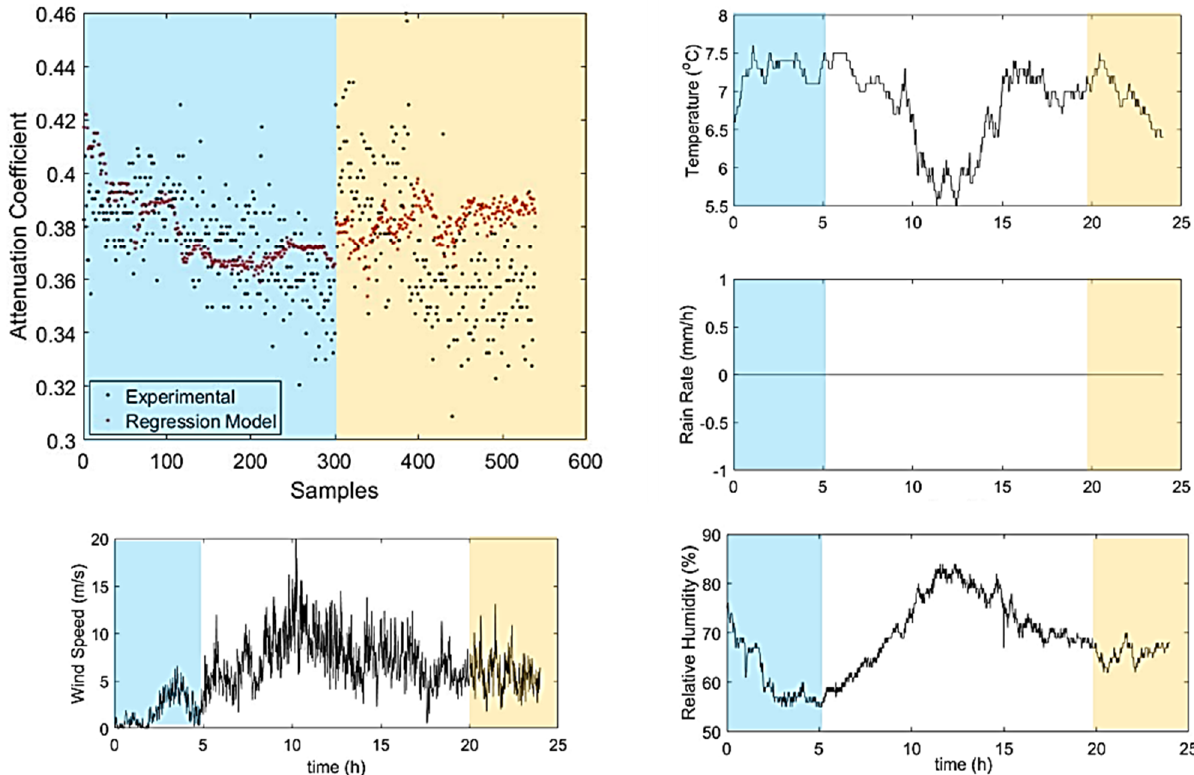
Figure 5. Experimental measurements and model predictions, i.e., Equation (6), for 6 February 2020.